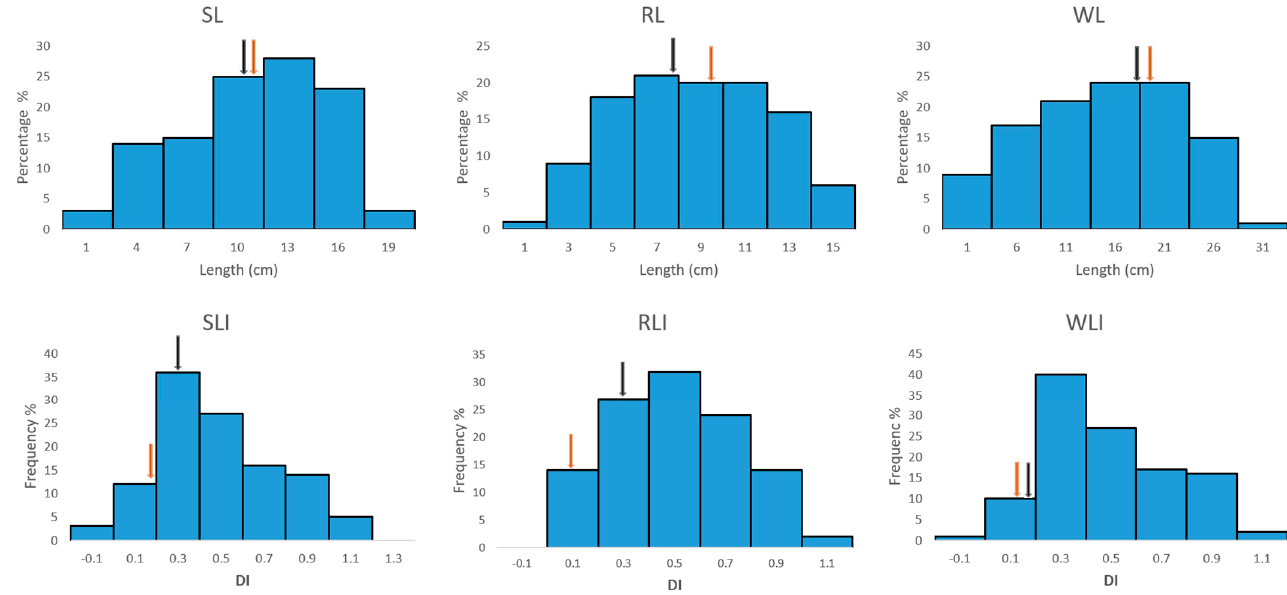
Figure 2. Frequency distribution of phenotypic variation for six traits among 111 RILs. SL, RL, and WL were shoot length, root length, and whole length values under 35 ◦ C heat stress condition, respectively. SLI, RLI, and WLI were damage indices of shoot length, root length, and whole length, respectively. The values for Synthetic W7984 and Opata M85 parental lines are indicated by black and red arrows, respectively. Values shown are means.